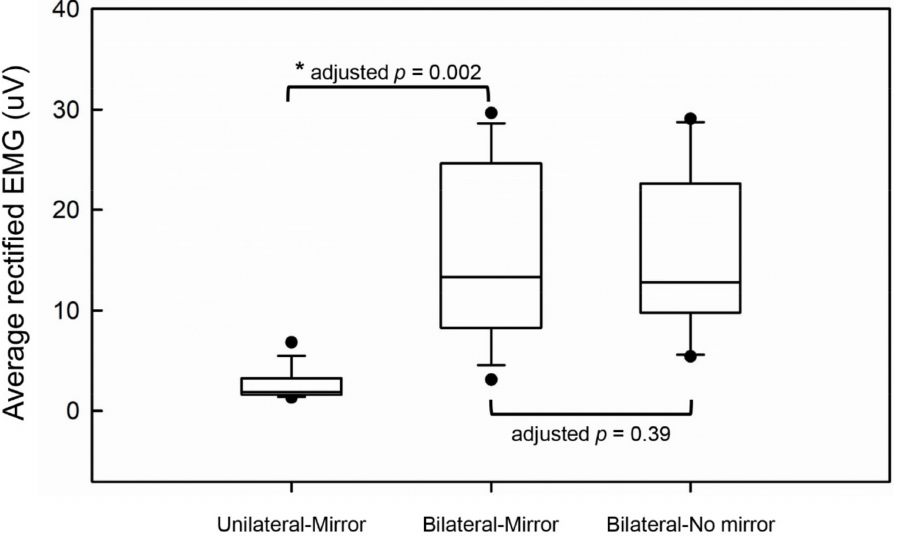
Figure 4. The comparisons of average rectified EMG activities between the experimental conditions. * represents a significant